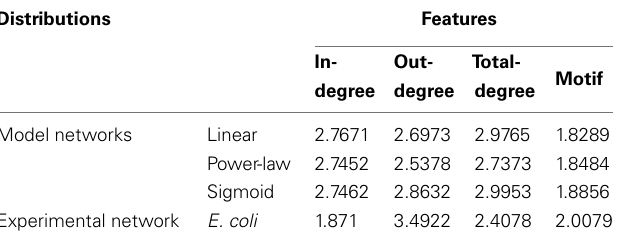
Table 2 | Scaling exponents α , defined for cumulative distribution